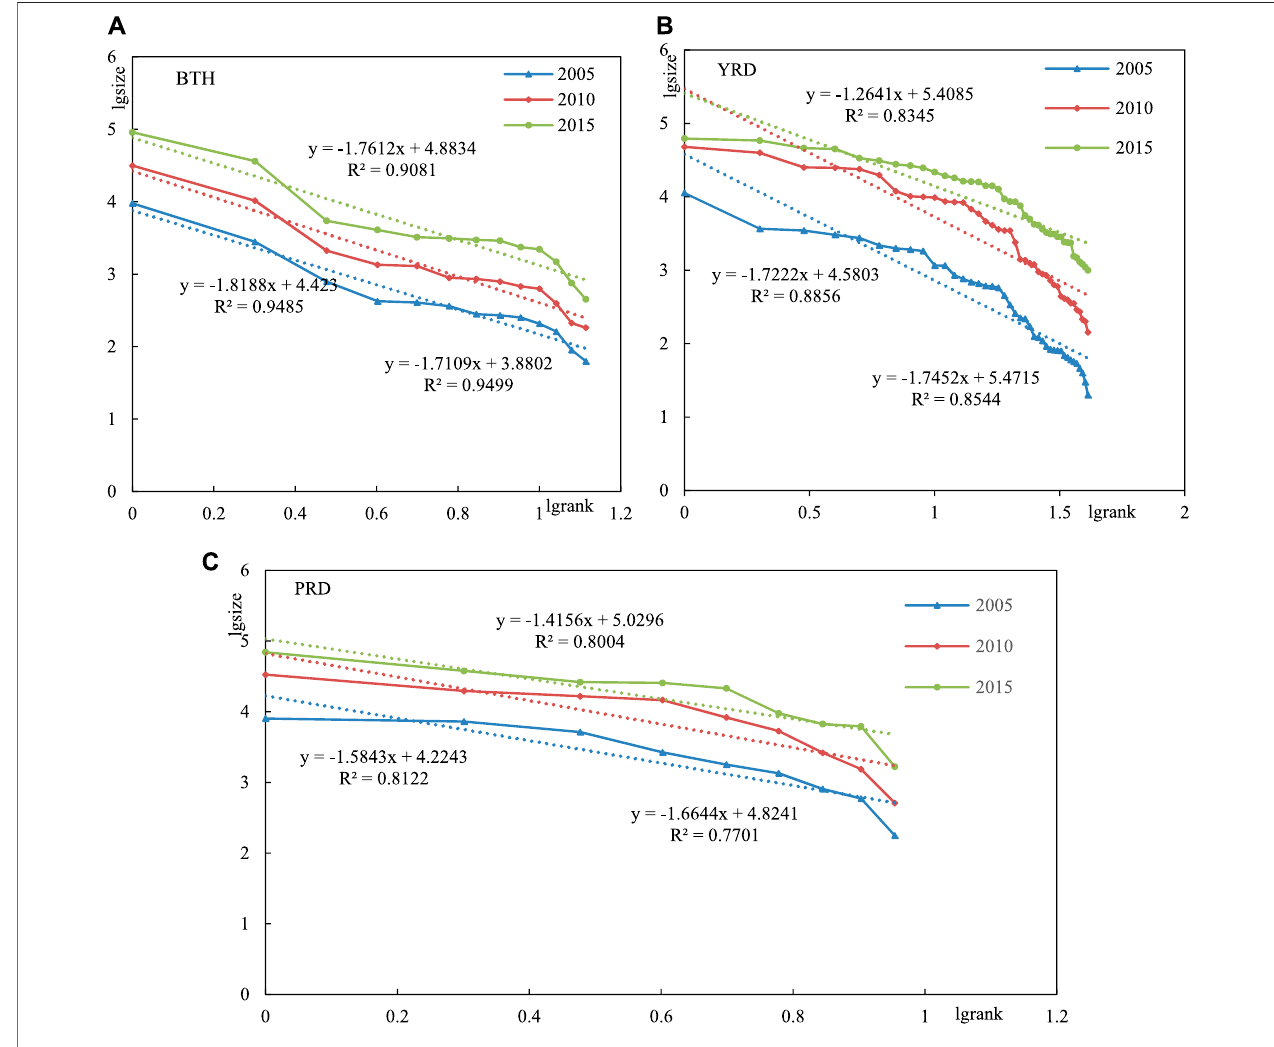
FIGURE 3 | The monocentricity-polycentricity evolution of three